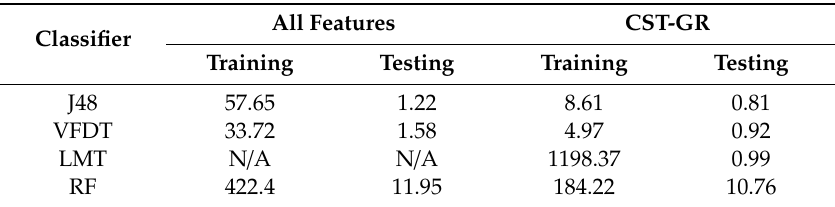
Table 4. Comparison of processing time (seconds). VFDT, very fast decision tree; LMT, logistic model tree; RF, random forest.